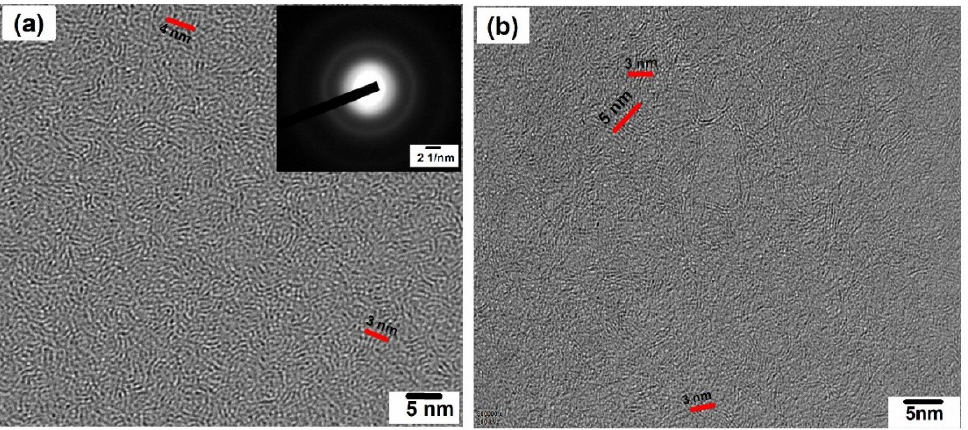
Figure 2. HRTEM micrograph of; (a) a sample a-carbon film (inset is the diffraction pattern); (b) a different area of the same sample.